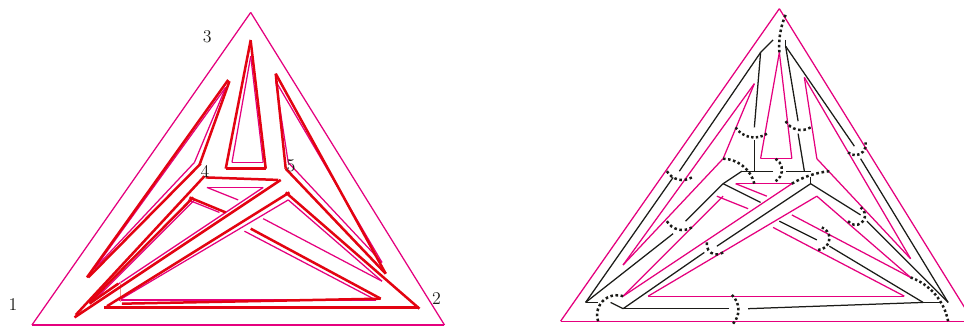
Figure 4 . The left panel shows the Heegaard diagram for the 4-simplex triangulation. The Heegaard surface is of genus six. Six of the ten attaching curves for the 2-handles are shown. The other four curves are generated from these six curves. Note that the curve for the triangle t (124) under-crosses the handle representing the edge e (15). The right panel shows a B 1 basis for the 4-simplex triangulation. For each vertex of the triangulation one can choose a cutting of the associated four-punctured sphere into two three-punctured ones. Again we have not shown the over-crossing graph copy. Using the 2-handle vacuum loops, as well as the vacuum loop around the edge e (15), one can transform the over-crossing graph copy to the 2-handle vacuum